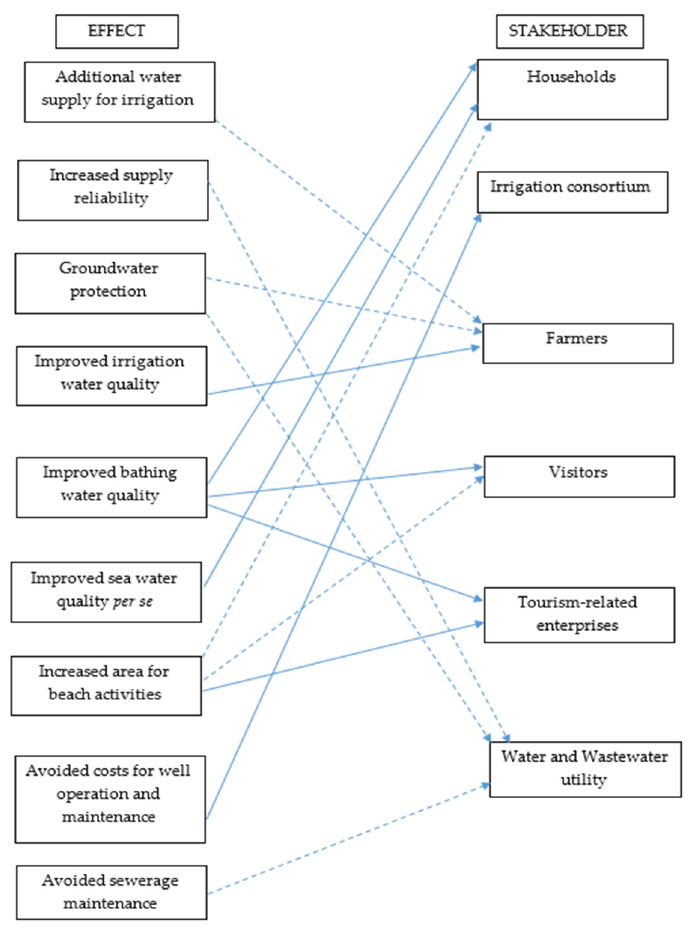
Figure 2. Potential e ff ects generated by the project and a ff ected stakeholders. Dotted lines indicate potential e ff ects that are not activated, given the specific conditions in terms of supply and